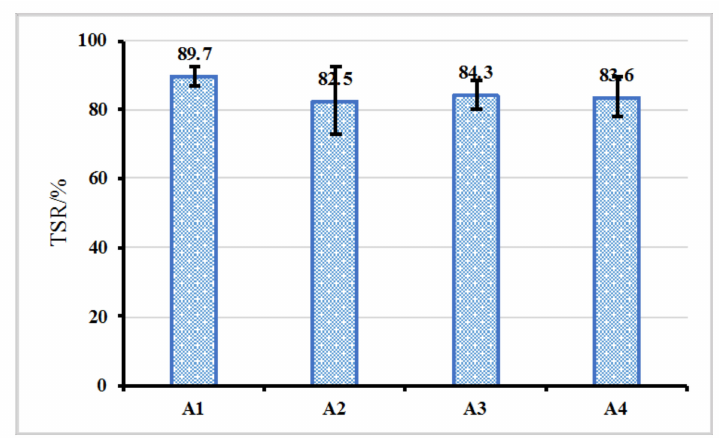
Figure 7. TSR of asphalt mixture with the fiber.